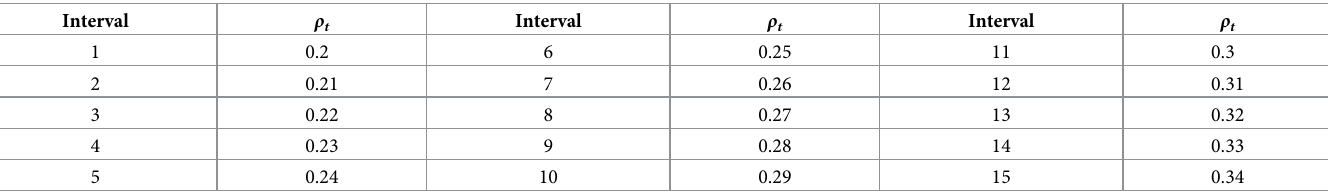
in all time intervals. t